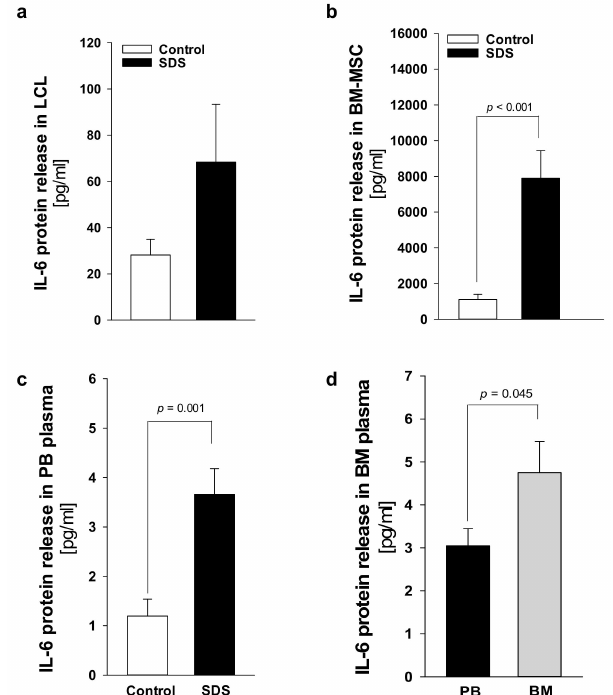
Figure 5. IL-6 release is elevated in SDS specimens compared to age-matched donor controls. ( a ) Measurement of IL-6 released in supernatants collected from 1 × 10 6 LCL after 48h. Data are mean ± SEM of 10 experiments conducted on LCL obtained from UPN24, UPN26, UPN58, UPN68, UPN75, and UPN106. ( b ) IL-6 released in supernatants collected from 2 × 10 5 primary BM-MSC after 48 h. ( c ) IL-6 concentration in peripheral blood (PB) plasma samples obtained from 21 patients with SDS (UPN1, 13, 26, 37, 47, 52, 56, 57, 58, 63, 65, 66, 69, 72, 73, 74, 87, 94, 104, 106, 108) compared with age-matched plasma controls. ( d ) IL-6 concentration in bone marrow (BM) plasma samples obtained from eight patients with SDS (UPN 47, 56, 65, 74, 87, 94, 106, 108) compared to PB plasma samples obtained from the same patients. Normal distribution was tested by the Shapiro–Wilk test. The Mann–Whitney Rank Sum Test was calculated and reported within